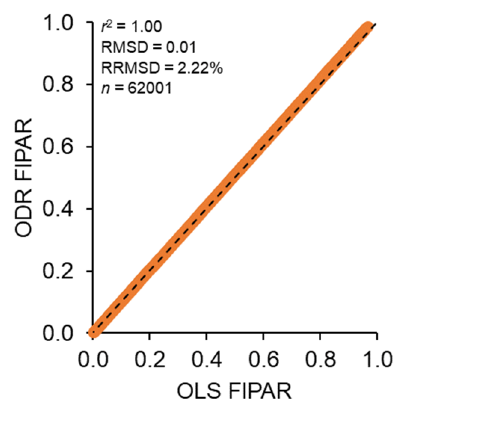
( d ) Figure 11. Comparison between ODR- and IRLS-based high-spatial-resolution reference maps of FIPAR ( left ) and CCC ( right ) for the Las Tiesas–Barrax ( a , b ) and Wytham Woods ( c , d ) campaigns. The dashed line represents a 1:1 relationship.